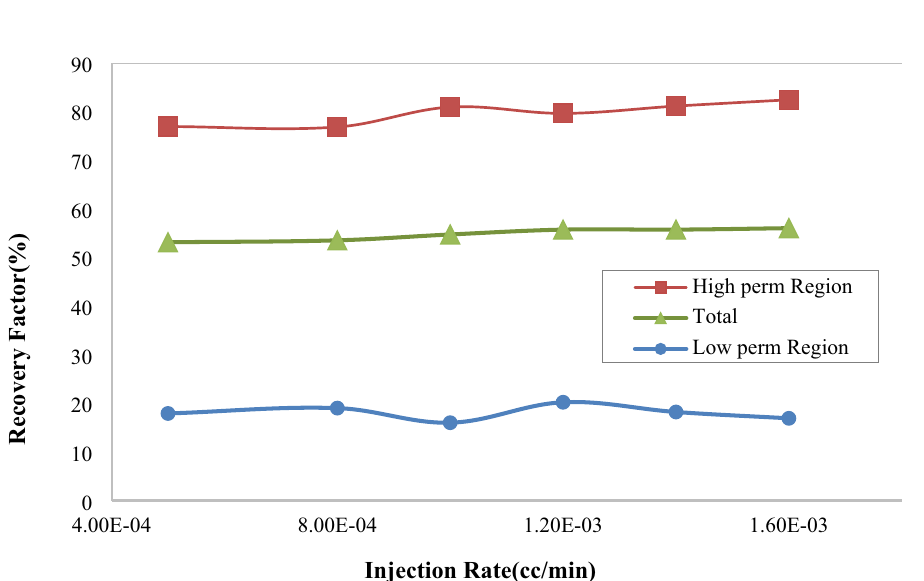
Figure 16. Effect of hydrogel injection rate on oil recovery factor in high and low permeability regions and the whole